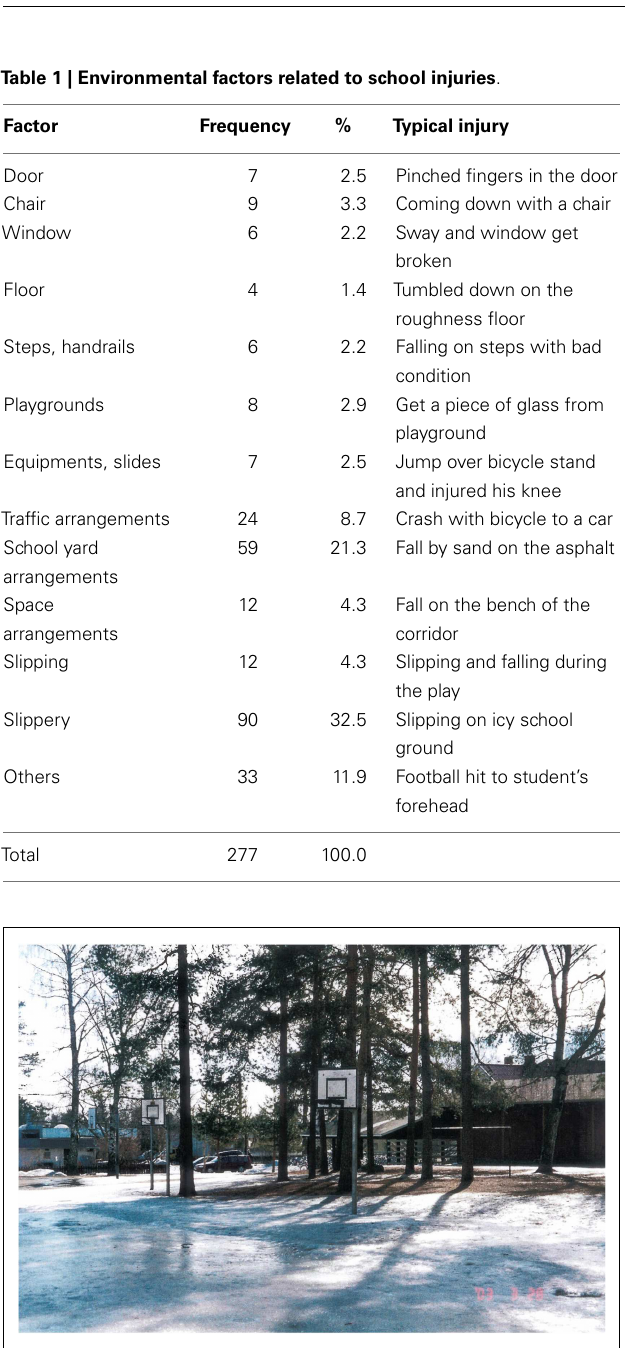
FIGURE 1 |The Finnish school yard during the wintertime